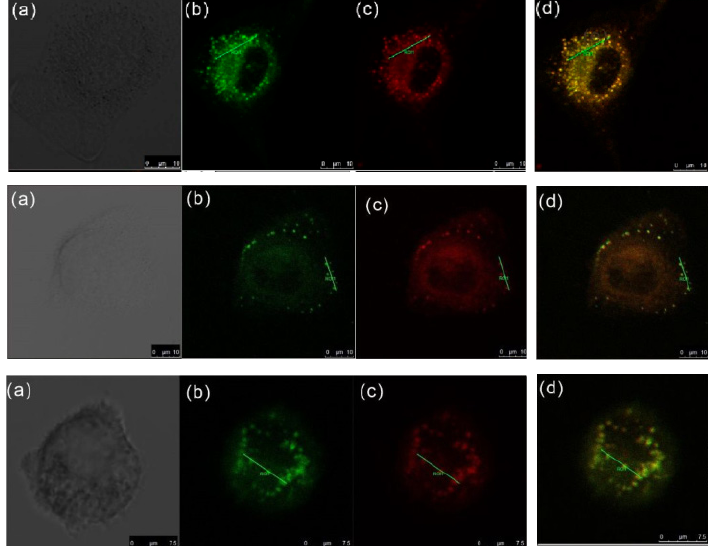
Figure 20. Confocal fluorescence images of HeLa cells with probes 23a – c and LDs Tracker Nile Red. ( a ) Bright field image, ( b ) probes 23a – c fluorescence under a green channel ( row 1 : 23a , row 2 : 23b , row 3 : 23c ), ( c ) LDs Tracker Nile Red fluorescence under a red channel, and ( d ) merged image. Adapted from